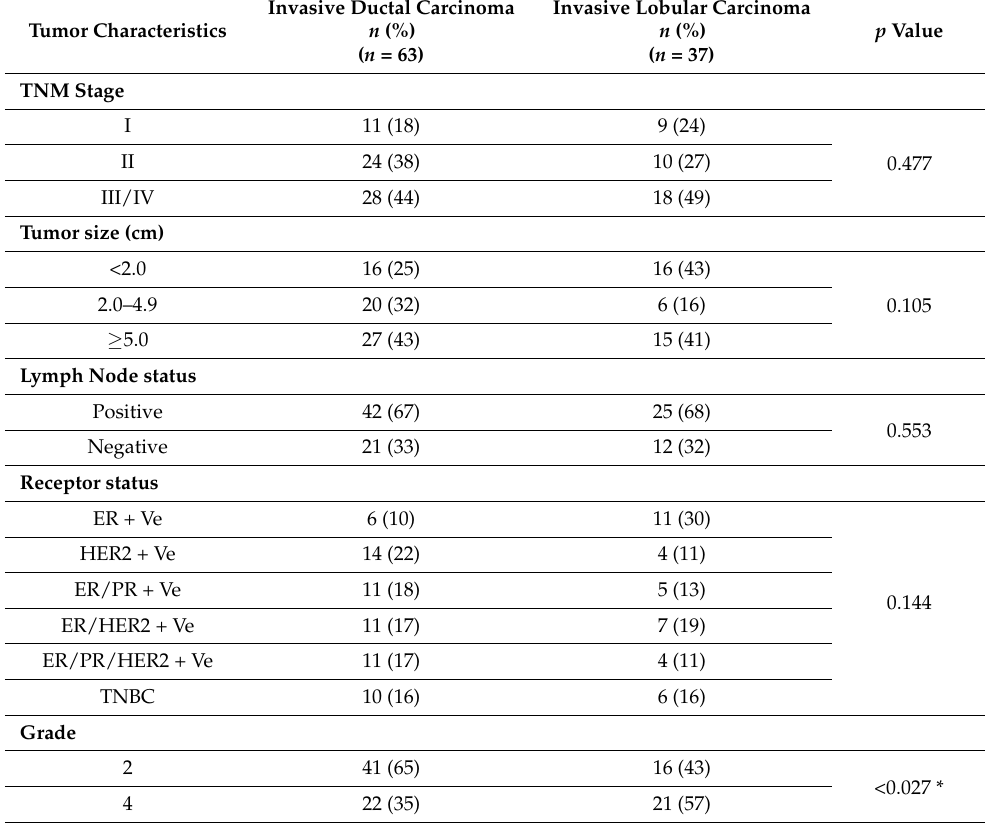
Table 2. Clinical characteristics of women with breast